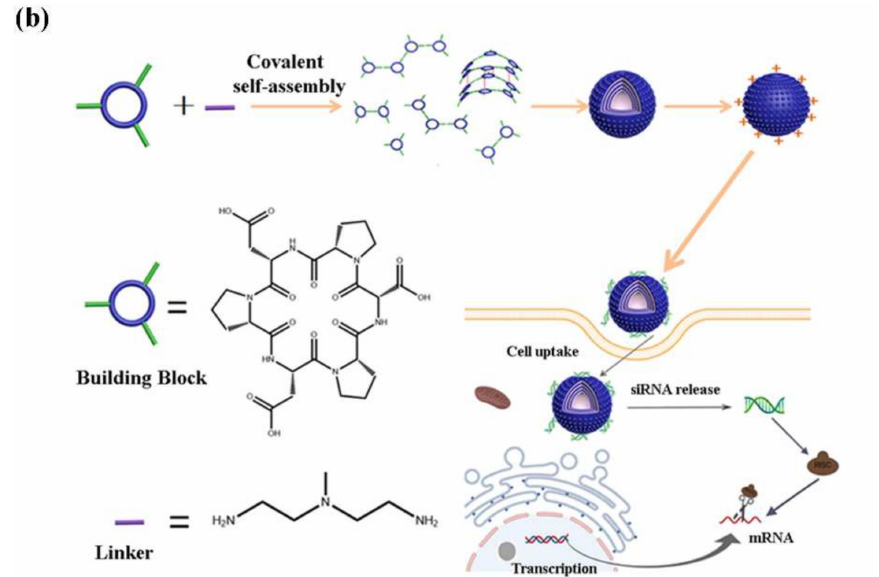
Figure 1. Schematic representation of cyclic peptide nanospheres for siRNA delivery. ( a ) Schematic diagram of the self-assembly of cyclo-(DP) 3 , and 2,2 (cid:48) -diamino-N-methyldiethylamine and its methy- lation modification. ( b ) Schematic diagram of the design of (CP) 6 NS and the siRNA delivery for gene